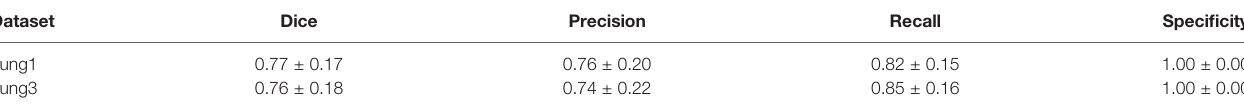
For the training dataset Lung1, the observed values are averaged over fi ve evaluation folds. For the validation dataset Lung3, the values are averaged over all samples. Note that we rounded to two digits so 1.00 in the last column results from rounding a value close to one.